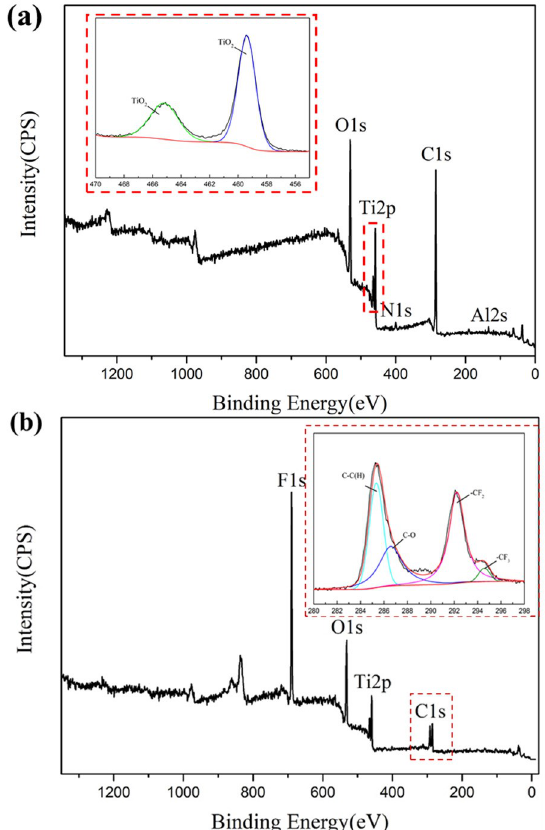
Figure 4. XPS spectra of the sample after the laser marking and anodizing ( a ) before FAS modification, and ( b ) after FAS modification; the insets are the enlarged image of chosen